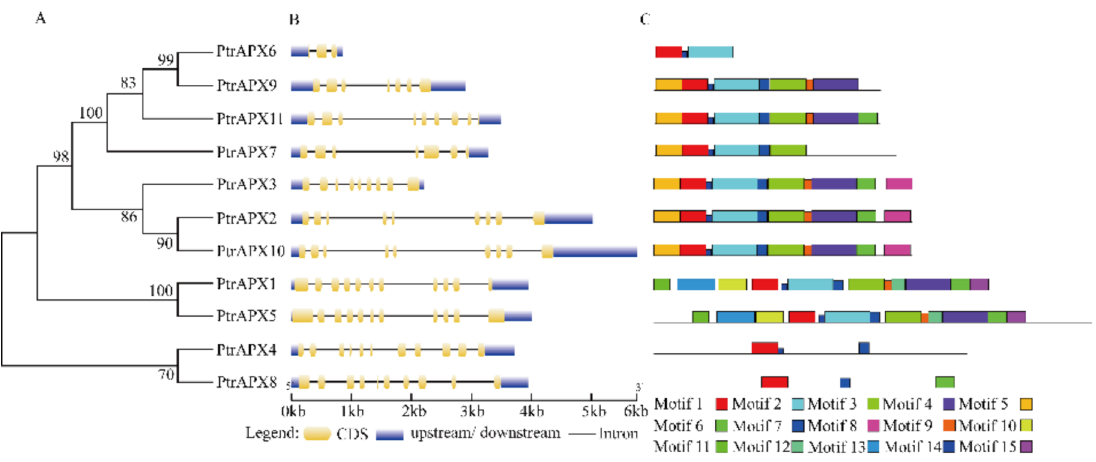
Figure 2. Phylogenetic tree, gene structure, and conserved motif analysis of the 11 PtrAPX genes. ( A ) A multiple alignment of the full-length PtrAPX protein sequences was generated using Clustal X 2.0. The phylogenetic tree was constructed using the neighbor-joining method with 1000 bootstrap replicates using MEGA 7.0. ( B ) Intron–extron structure of the corresponding PtrAPX genes. ( C ) Conserved motifs of PtrAPX genes predicted by the MEME tool. The motif numbers 1–15 are represented by boxes of different